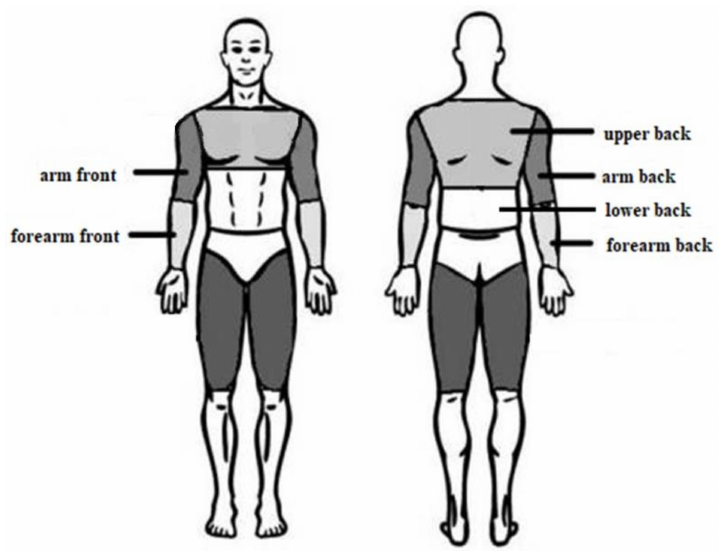
Figure 1. Analyzed body